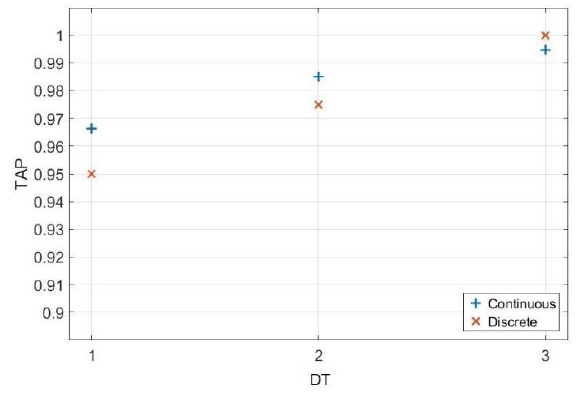
Figure 9. Continuous and discrete adjustment of taps, 20% PV.